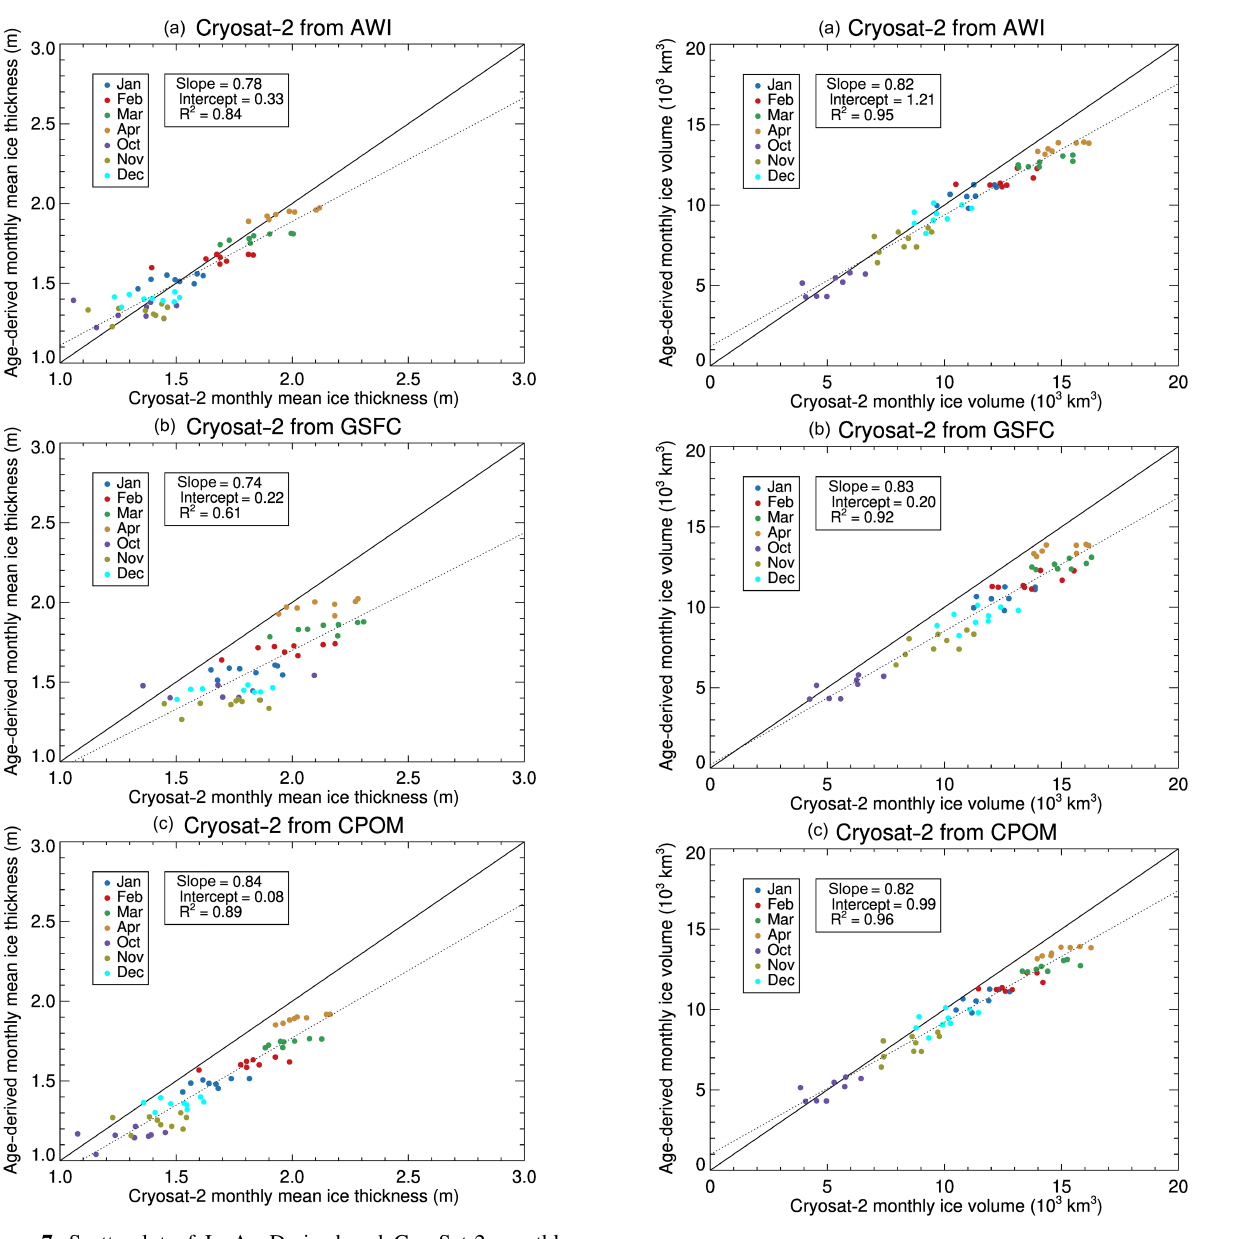
Figure 8. Same as Fig. 7 but for monthly ice